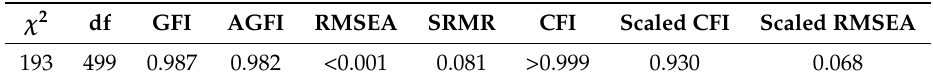
Figure 1. Graph of our main structural equation model showing the correlation between each pair of latent factors and the standardized loadings with respect to each observed item in the questionnaire. The individual standardized exogenous error variance for every observed item is also displayed. Table 3. Fit indices of the structural equation model of Figure 1. AGFI, adjusted goodness-of-fit index; CFI, comparative fit